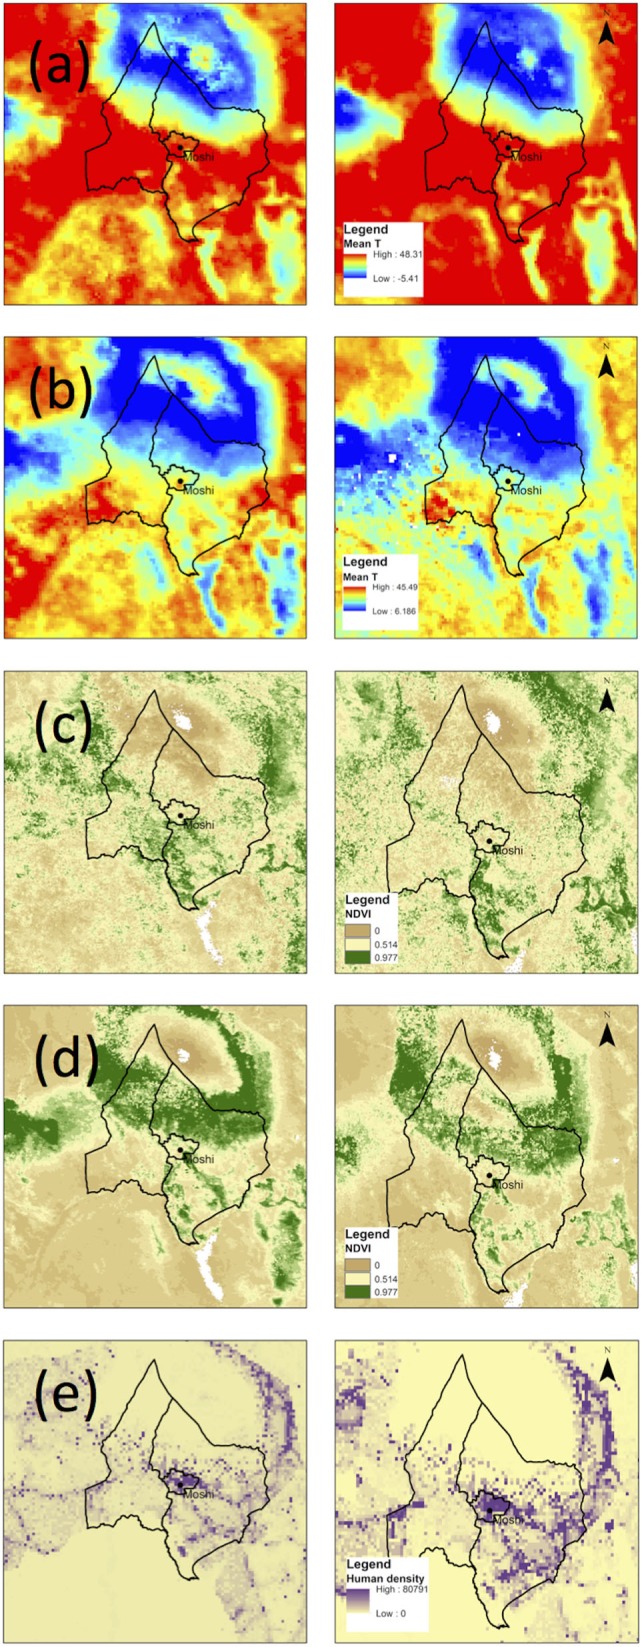
Maps of environmental factors (A) TH, (B) TC, (C) NDVIW, (D) NDVID, and (E) human population density in the study area in 2004 (left column) and 2014 (right column).